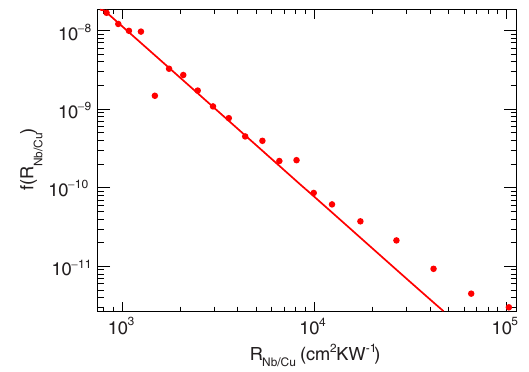
FIG. 6. Typical result of the fitting procedure of the thermal model (cavity QP1.4 in this